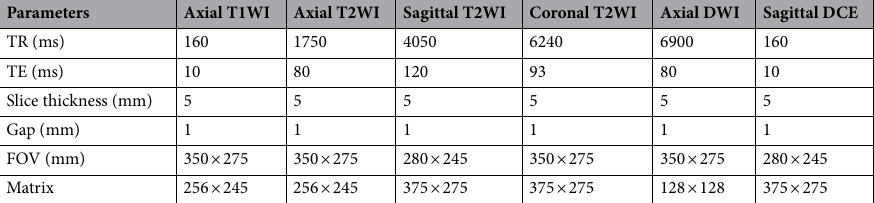
Table 1. Imaging protocol for patients. TR repetition time, TE echo time, FOV Field of view, DCE dynamic contrast